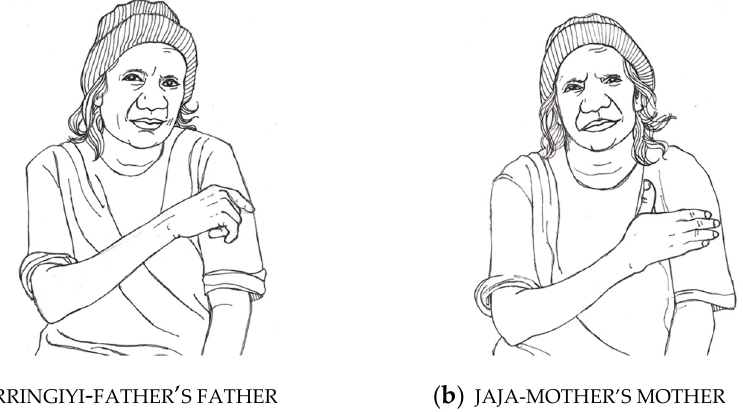
MOTHER Figure 3. Warlpiri minimal pair for handshape ( a ) WARRINGIYI - FATHER ’ S FATHER etc ( b ) JAJA - Figure 3. Warlpiri minimal pair for handshape ( a ) WARRINGIYI — FATHER ’ S FATHER etc ( b ) JAJA — MOTHER ’ S MOTHER , etc. (Illustrations: Jennifer Taylor). 18 MOTHER ’ S MOTHER , etc. (Illustrations: Jennifer Taylor). 18 .